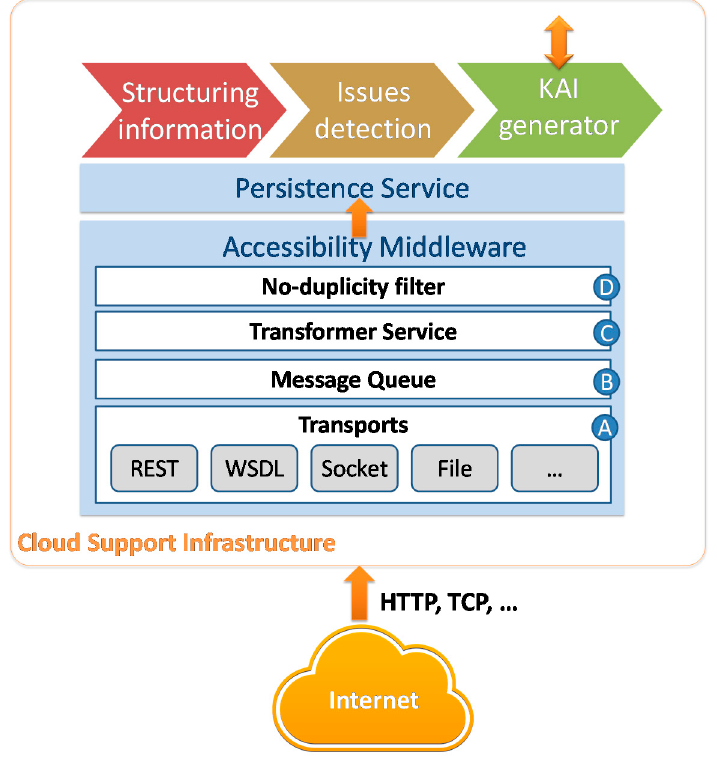
Figure 5. Components of the Cloud Support Infrastructure.